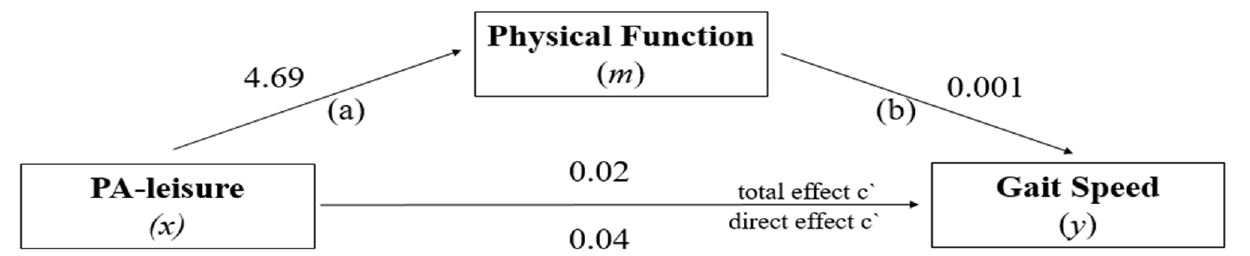
Figure 6. PF model as a mediator of the effect of PA-leisure on GS.